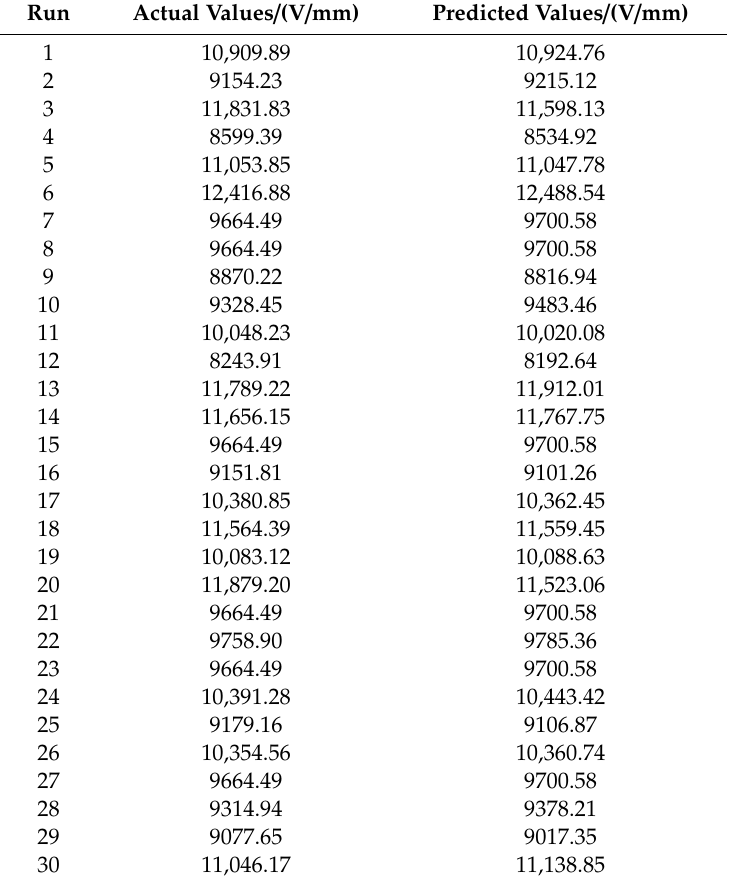
Table 9. Comparisons between predicted and actual